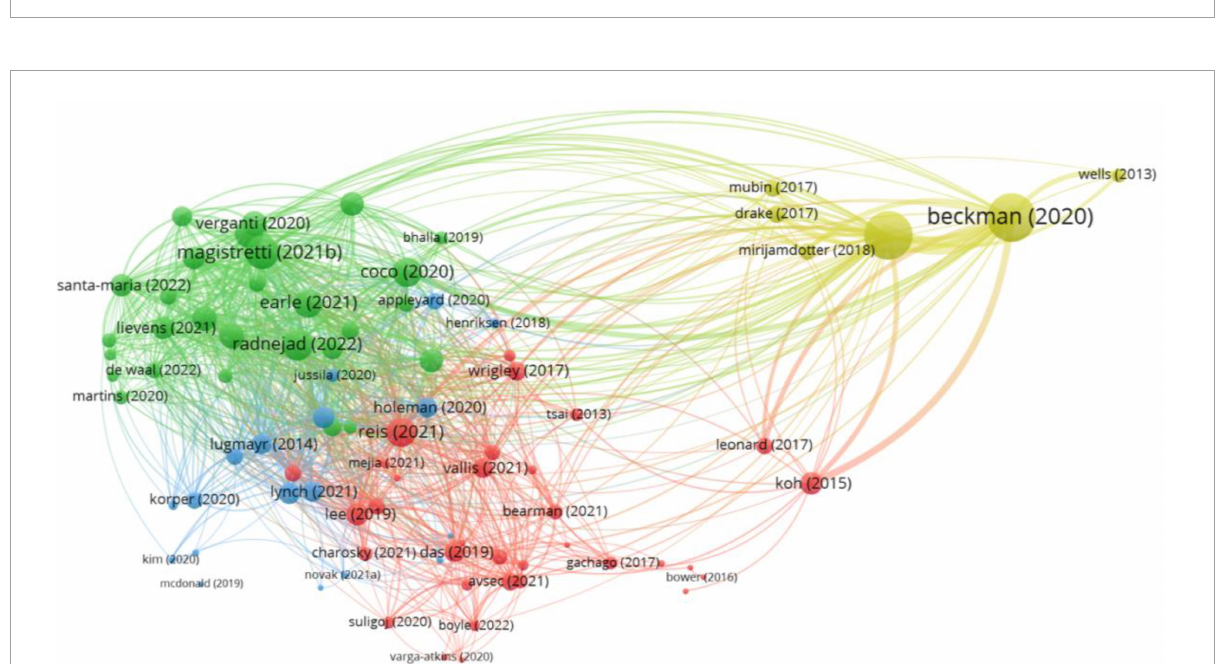
FIGURE2 Visualisation network of the current state of DT field related to (competencies in) digital era; bibliographic coupling